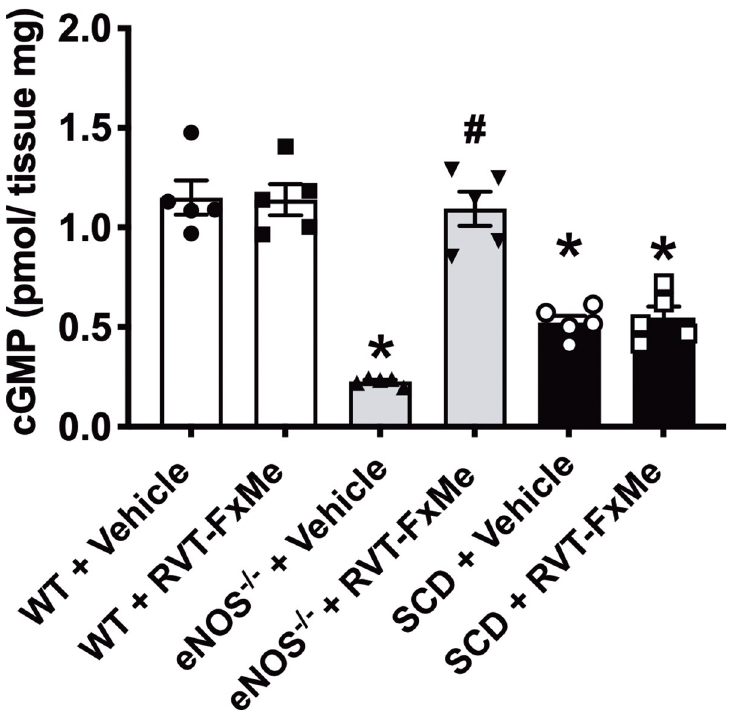
Fig 7. cGMP levels in penises of WT, eNOS -/- and SCD mice treated with RVT-FxMe (25 mg/kg/day, 2 weeks) or vehicle. Data represent the mean ± SEM for 5 mice in each group. One-way ANOVA: � P < .05 vs WT + Vehicle, # P < .05 vs respective vehicle